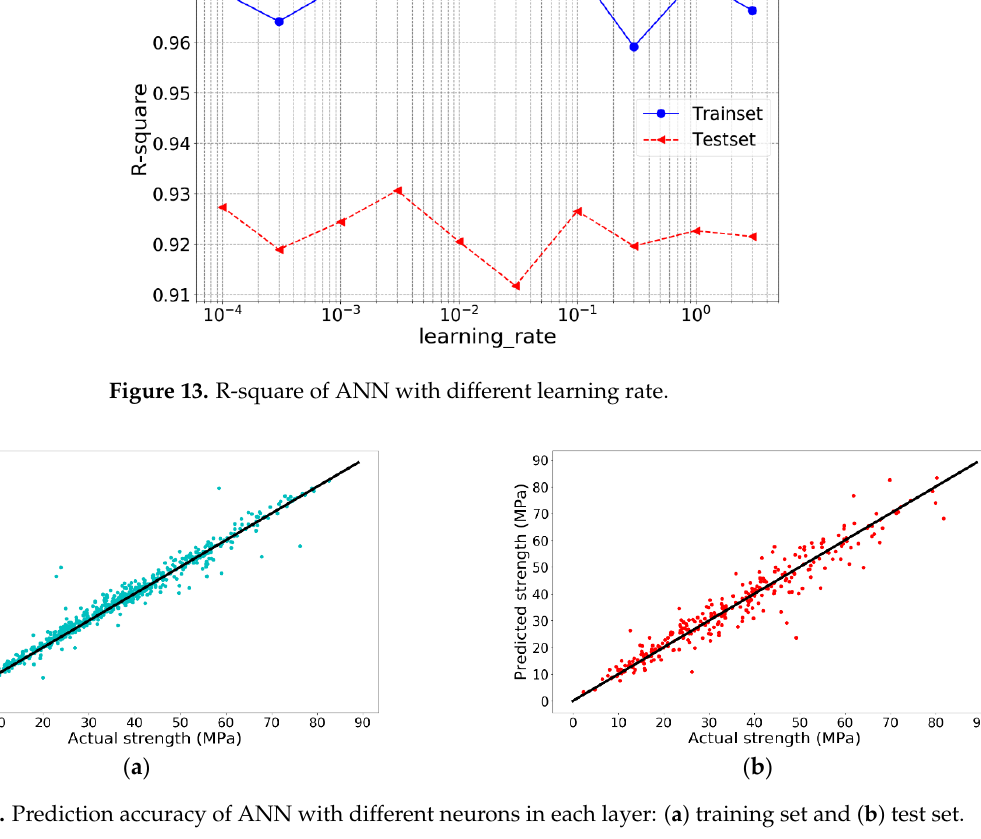
Figure 14. Prediction accuracy of ANN with different neurons in each layer: ( a ) training set and ( b ) test set